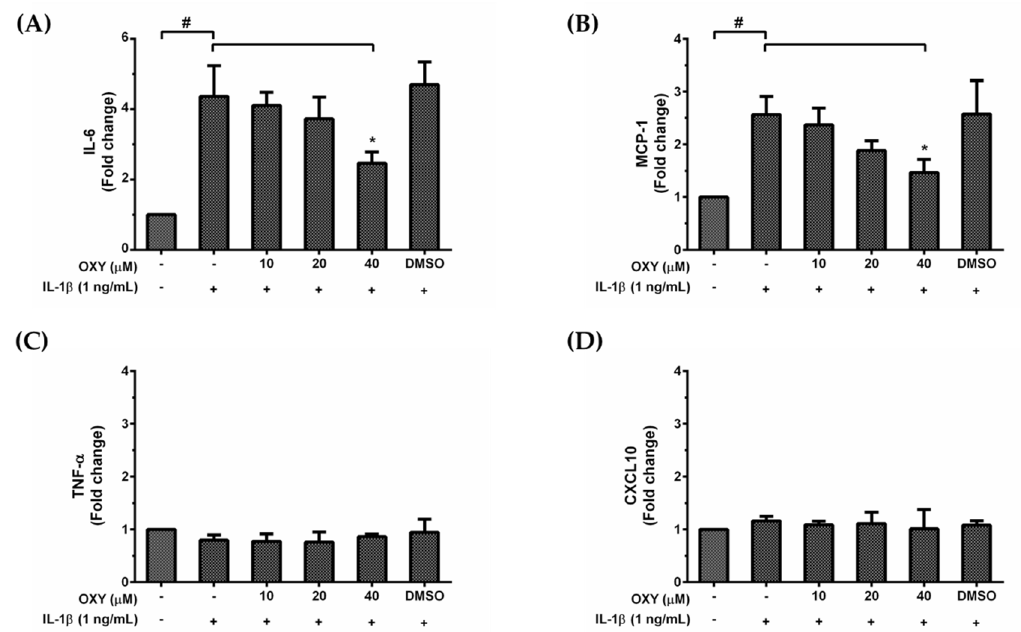
Figure 2. The roles of OXY on IL-1β-stimulated production of IL-6 ( A ), MCP-1 ( B ), TNF-α ( C ), and CXCL10 ( D ) in the supernatants of HMC3 cells pretreated with OXY at the different concentrations of 10, 20, and 40 μM for 4 h, and then induced with IL-1β (1 ng/mL) for 24 h. The bars indicate the secreted fold change of pro-inflammatory mediators which were determined by ELISA. Data are represented as mean ± SD of three independent experiments; # p < 0.05 (compared to the untreated group) or * p < 0.05 (compared to the IL-1β -treated group).